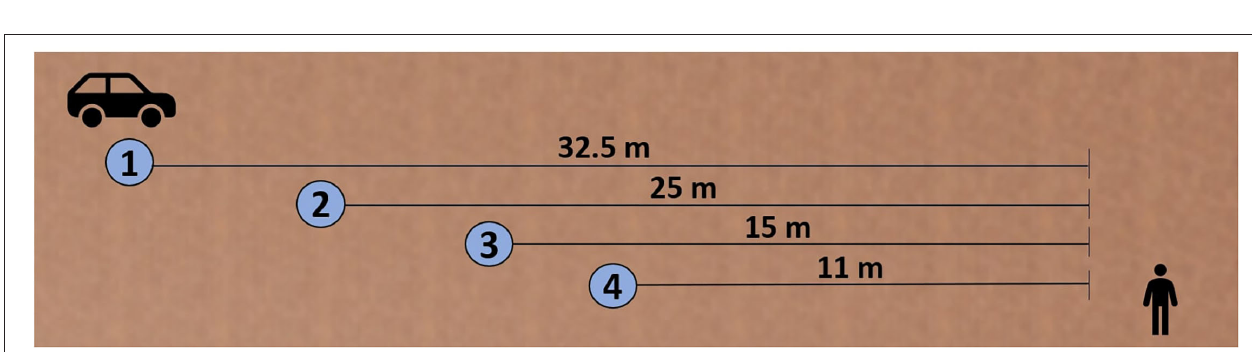
Frontiers in Psychology |